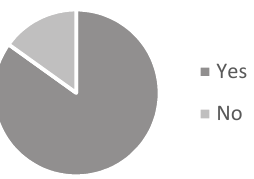
Figure A4. Previous experience with recycling, first survey (106 individuals).